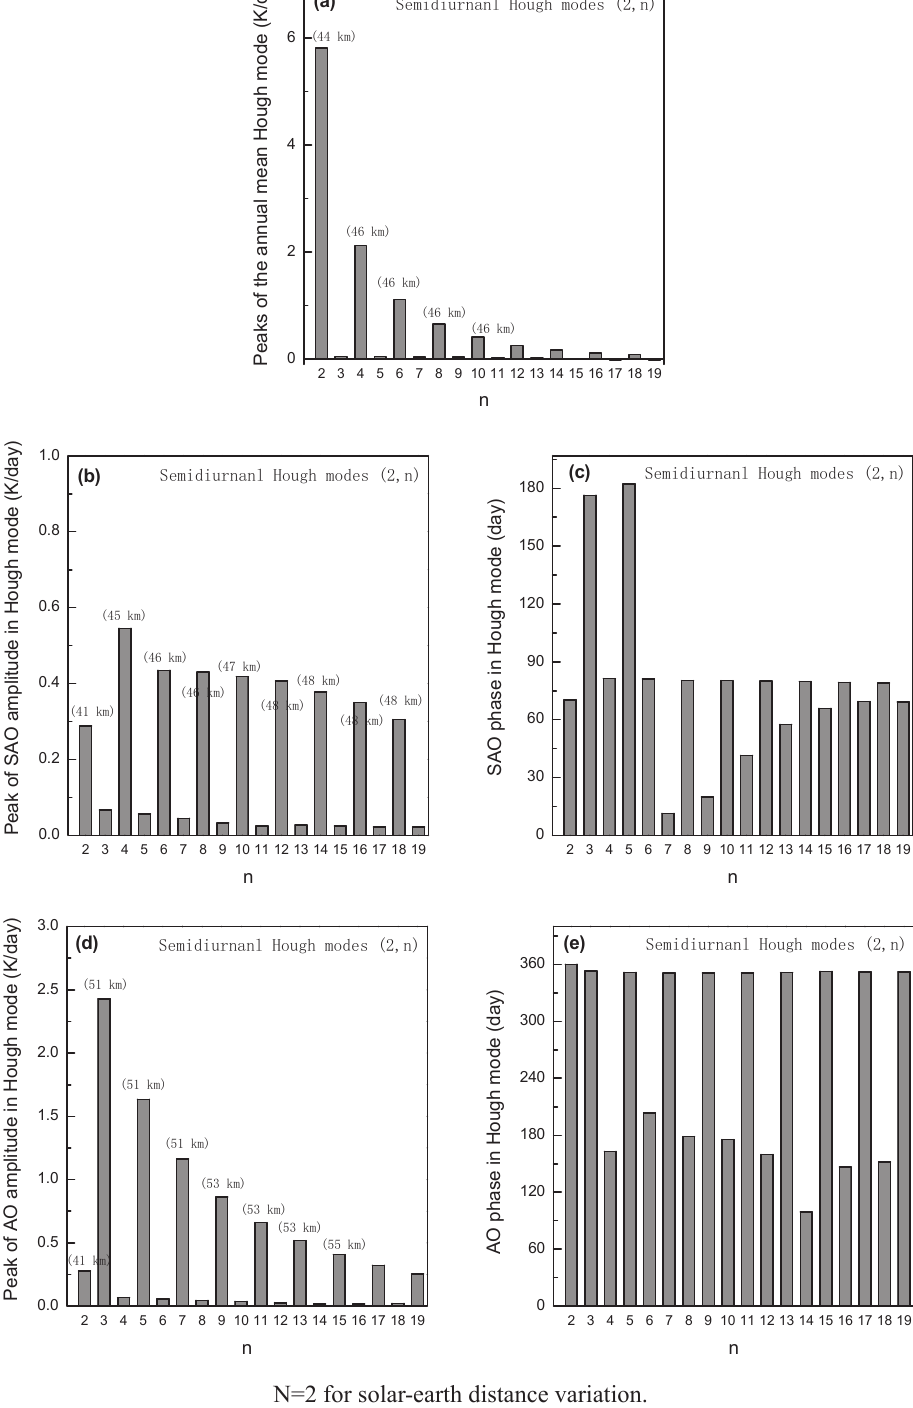
N=2 for solar-earth distance variation. Fig. 12. (a) The coefficients of the annual mean semidiurnal heating Hough modes (2, n) ; (b) and (c) the amplitudes and phases of the SAO in the semidiurnal heating Hough modes; (d) and (e) the amplitudes and phases of the AO in the semidiurnal heating Hough modes. The altitudes of the Hough mode peaks are given in brackets.